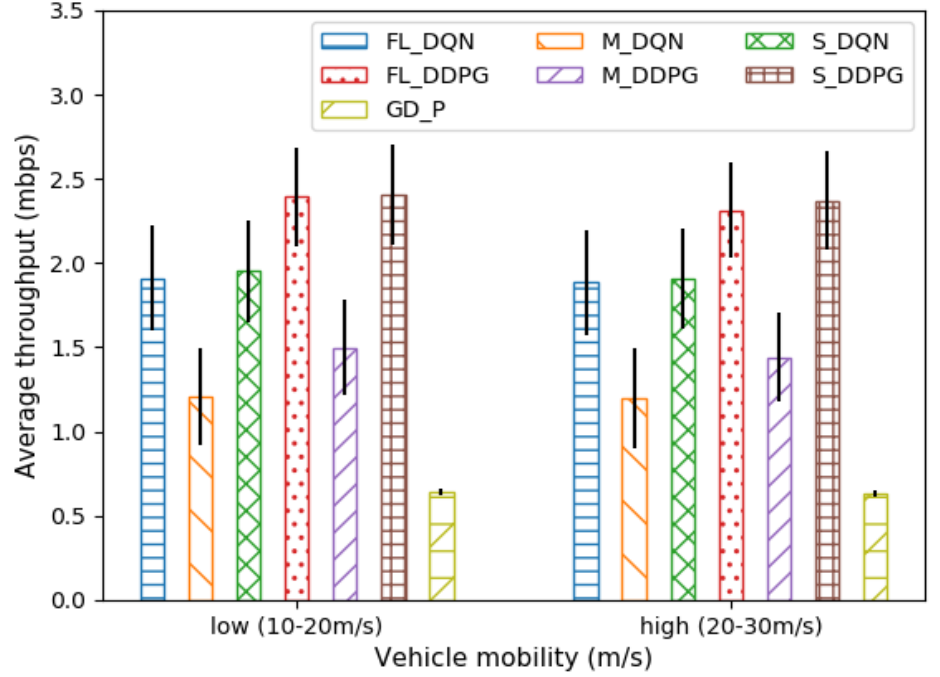
Figure 6. Comparison of average throughput under vehicle mobility.